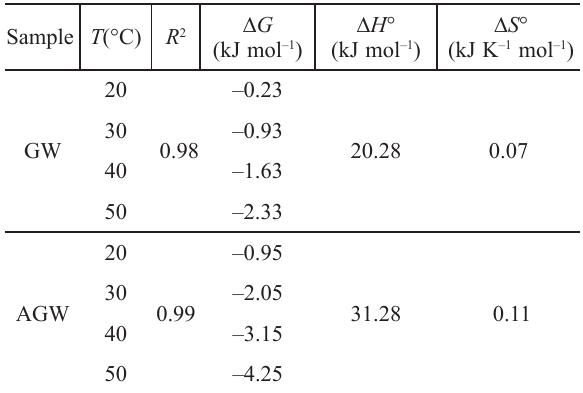
Table 6 – Thermodynamic parameters for Rhodamine B adsorption onto solid